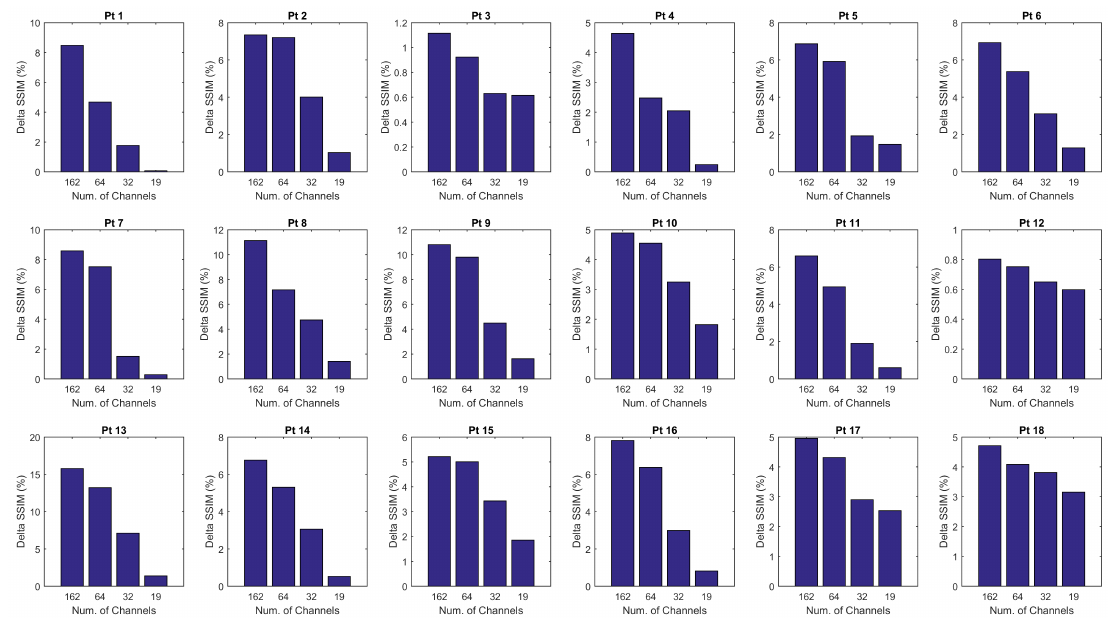
Figure 7. Effect of the number of channels on the estimated overall compressibility of the two hemispheres. For every patient, the percent difference between the areas under the two SSIM curves shown in Figure 5, denoted as ∆ SSIM , was calculated with 19, 32, 64 and 162 channels, all subsampled from 256